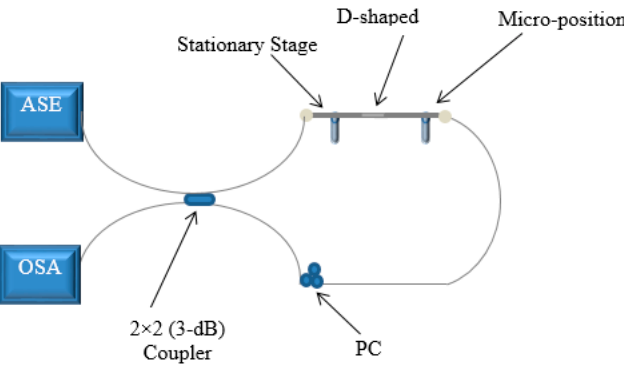
Figure 5. Schematic diagram of experimental setup of proposed strain and temperature sensor .